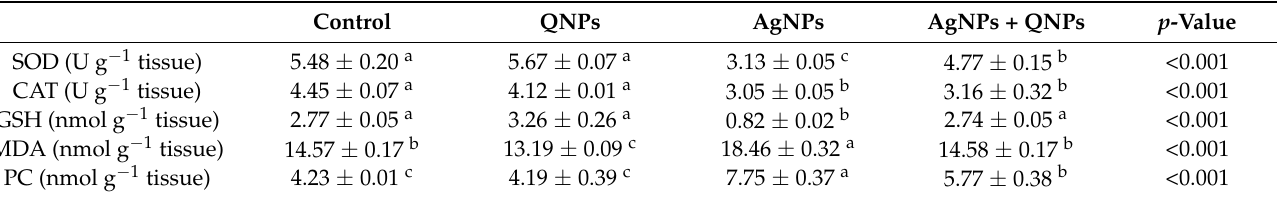
Table 4. Effect of QNPs on oxidative stress in AgNPs-induced toxicity in liver of Nile tilapia. Control